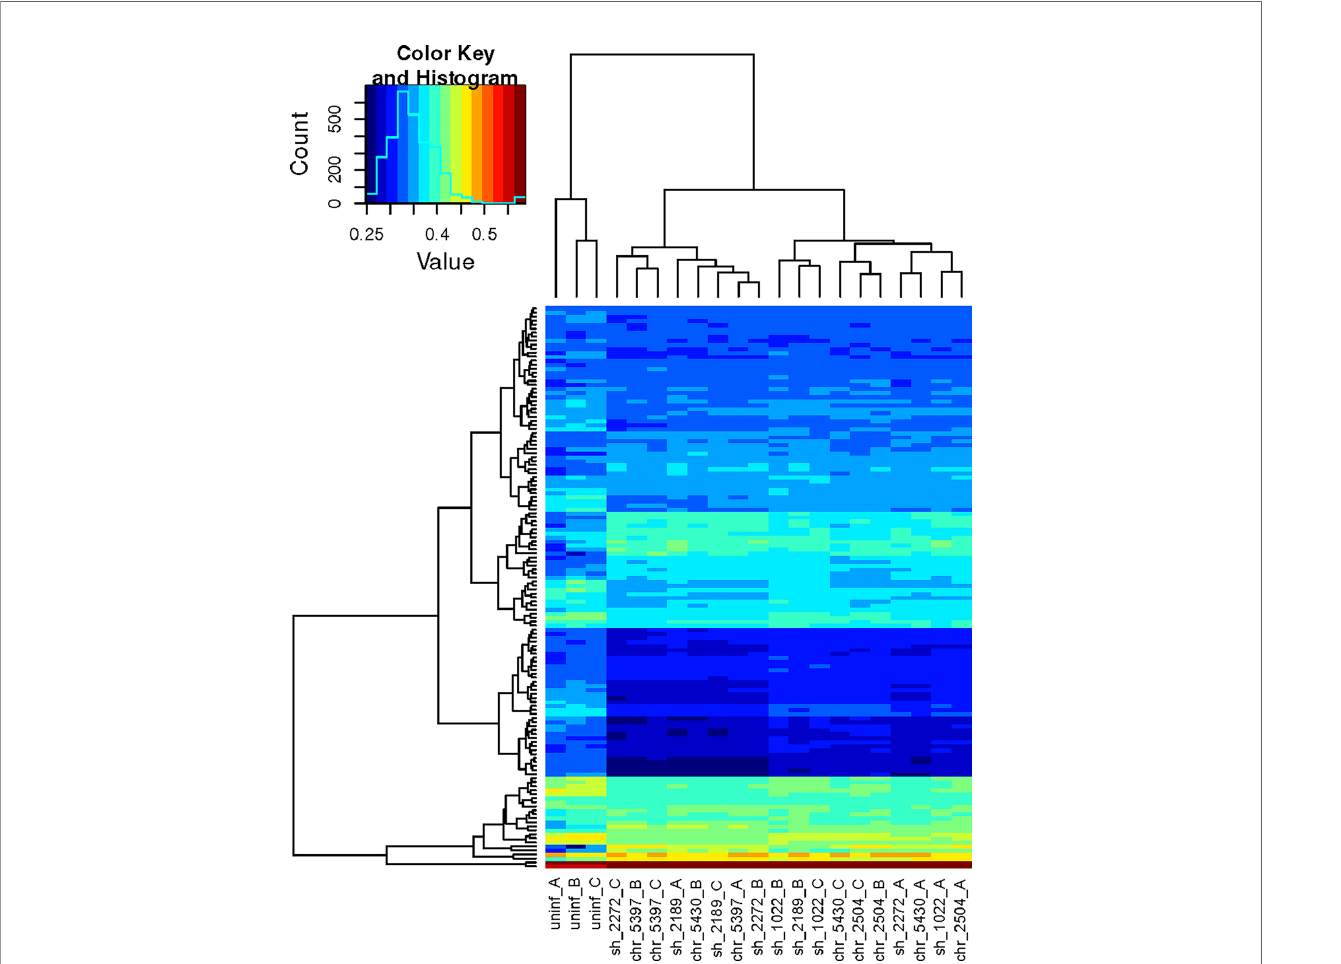
FIGURE 3 | Hierarchical clustering heatmap of signi fi cant mSigDB c7 gene sets. GSVA was performed using the normalized expression data and the mSigDB c7 gene sets. The resulting scored gene sets were examined using limma and by de-novo comparisons of the mean group scores in order to extract the most signi fi cant gene sets. The remaining scores were passed to a hierarchical clustering algorithm and plotted. Each column corresponds to an independent sample, each row to a unique gene set. Columns 1- 3, uninfected PBMCs from three independent healthy donors (A – C). Columns 4-18, infected PBMCs. Sample codes correspond to the phenotype of the disease caused by the Leishmania strain (sh, self healing; chr, chronic), followed by the strain code and the PBMC